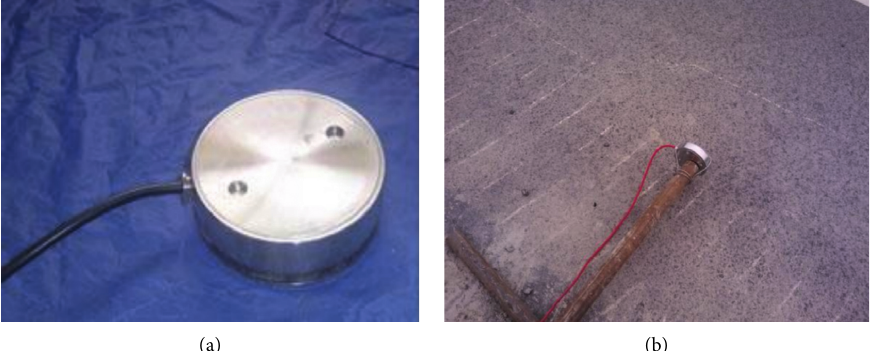
Figure 2: Installation and layout of the earth pressure boxes. (a) XB-150 double-membrane earth pressure cell. (b) Site of earth pressure box